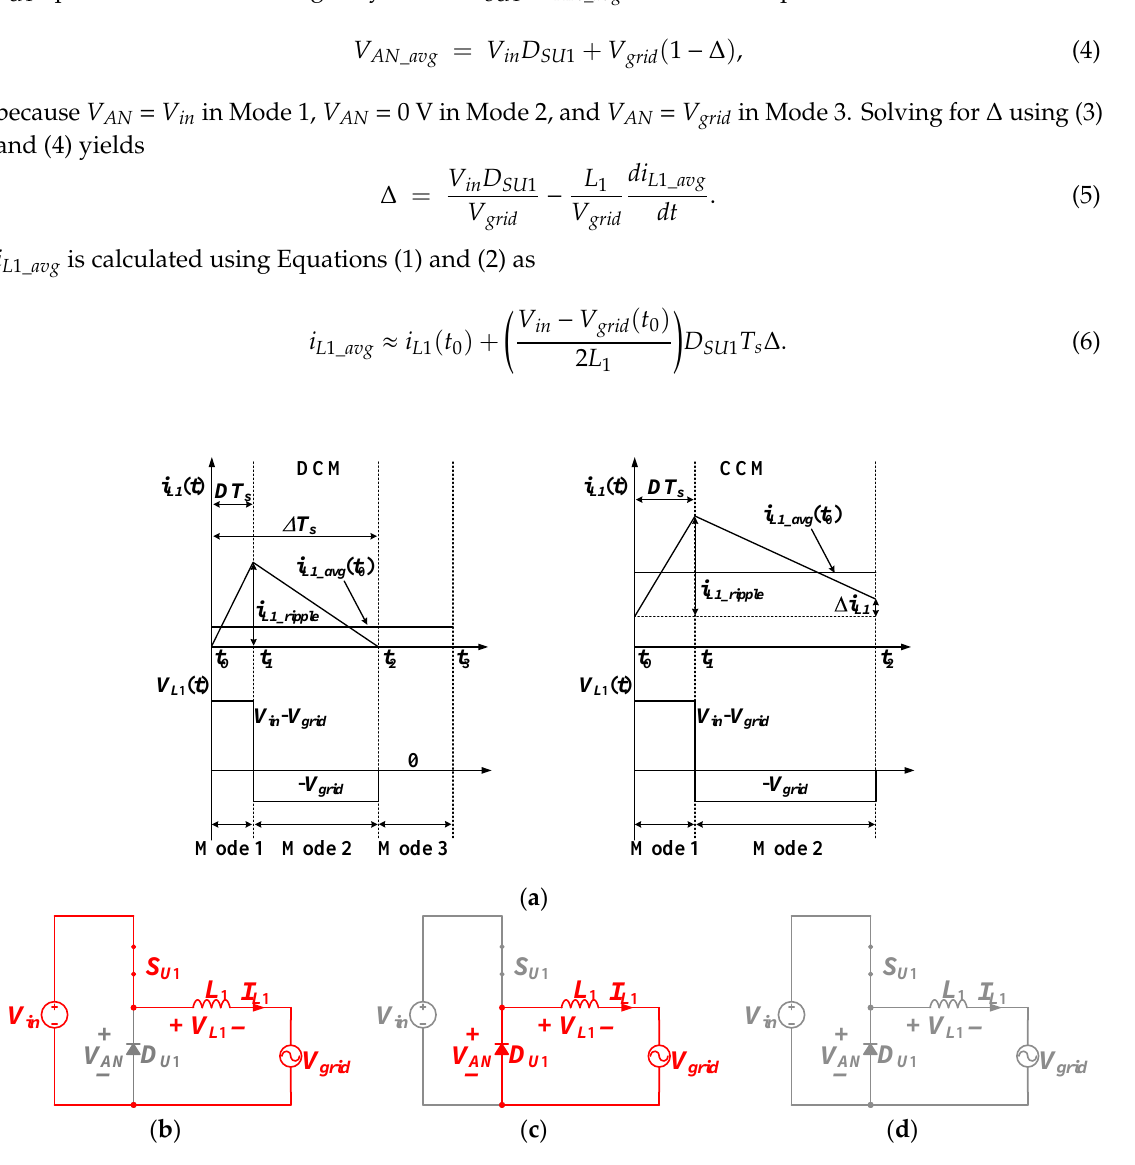
Figure 4. Theoretical waveforms and circuit diagrams for leg 1: ( a ) V L 1 and i L 1 for DCM and CCM operation, ( b ) circuit diagrams for Mode 1, ( c ) circuit diagrams for Mode 2, and ( d ) circuit diagrams for Mode 3.